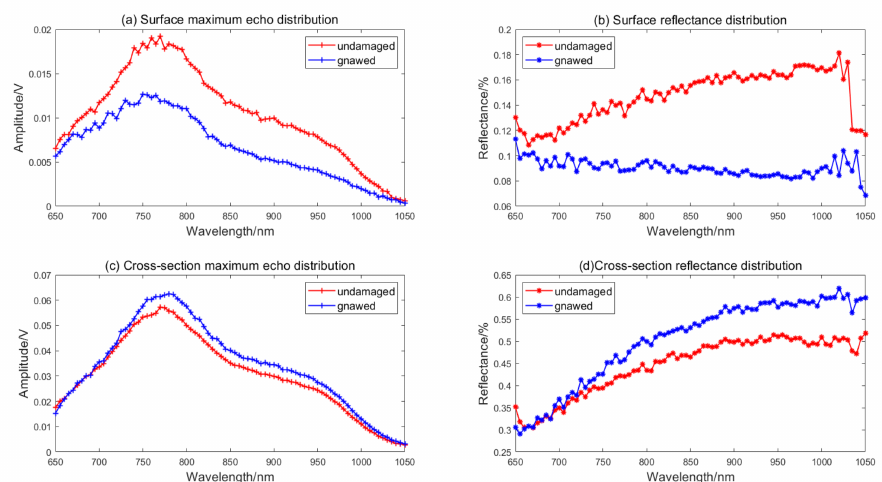
Figure 10. Comparison of the gnawed component with the undamaged one. ( a ) Surface maximum echo distribution. ( b ) Surface reflectance distribution. ( c ) Cross section maximum echo distribution. ( d ) Cross section reflectance